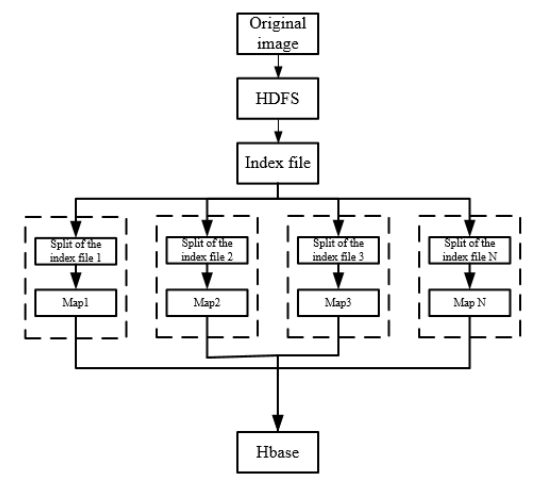
Figure 2. Feature Extraction based on